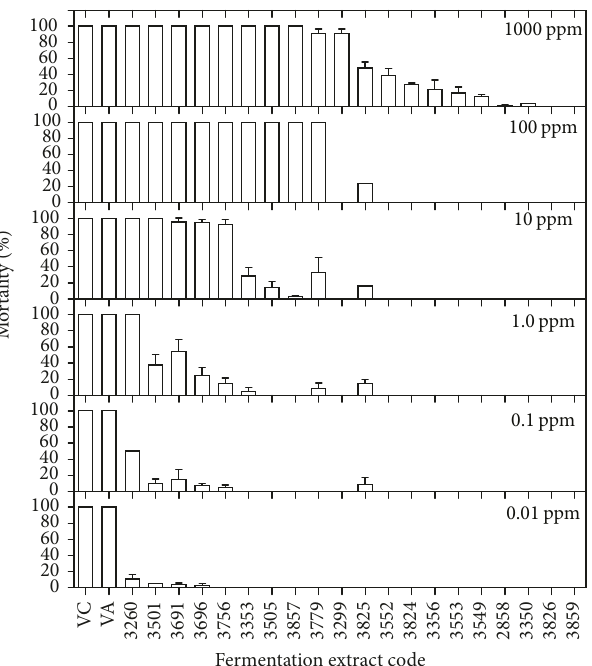
Figure 2: Toxicity of Bacillus thuringiensis var. israelensis fermenta- tion extracts at different concentrations against Aedes aegypti (VC, commercial VectoBac; VA, activated